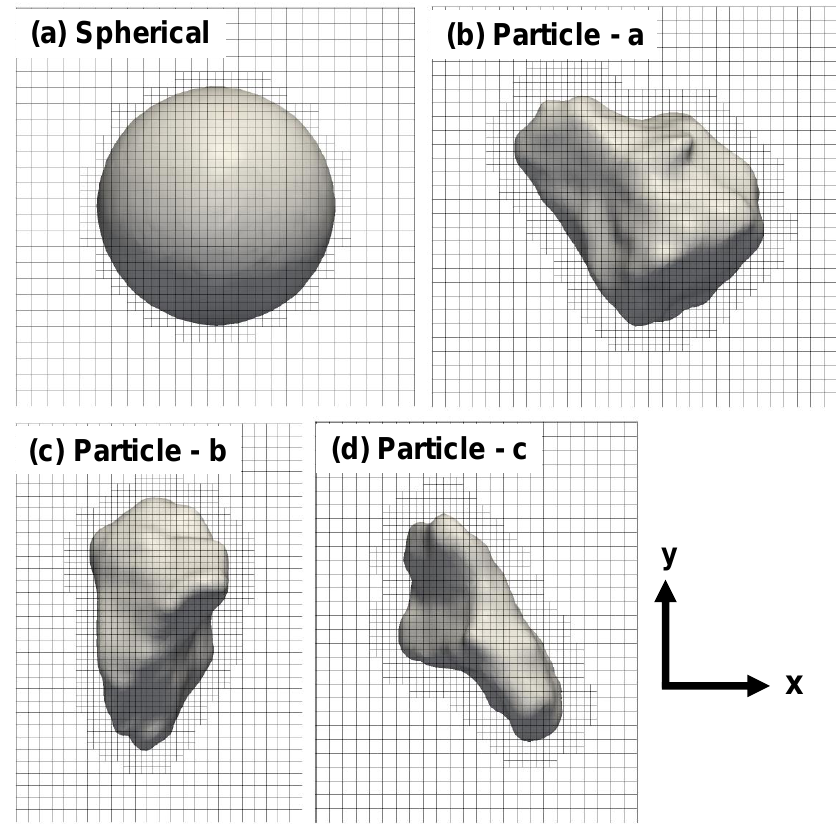
Figure 3. X-Y view of particles in mesh wireframe used in the convergence study.